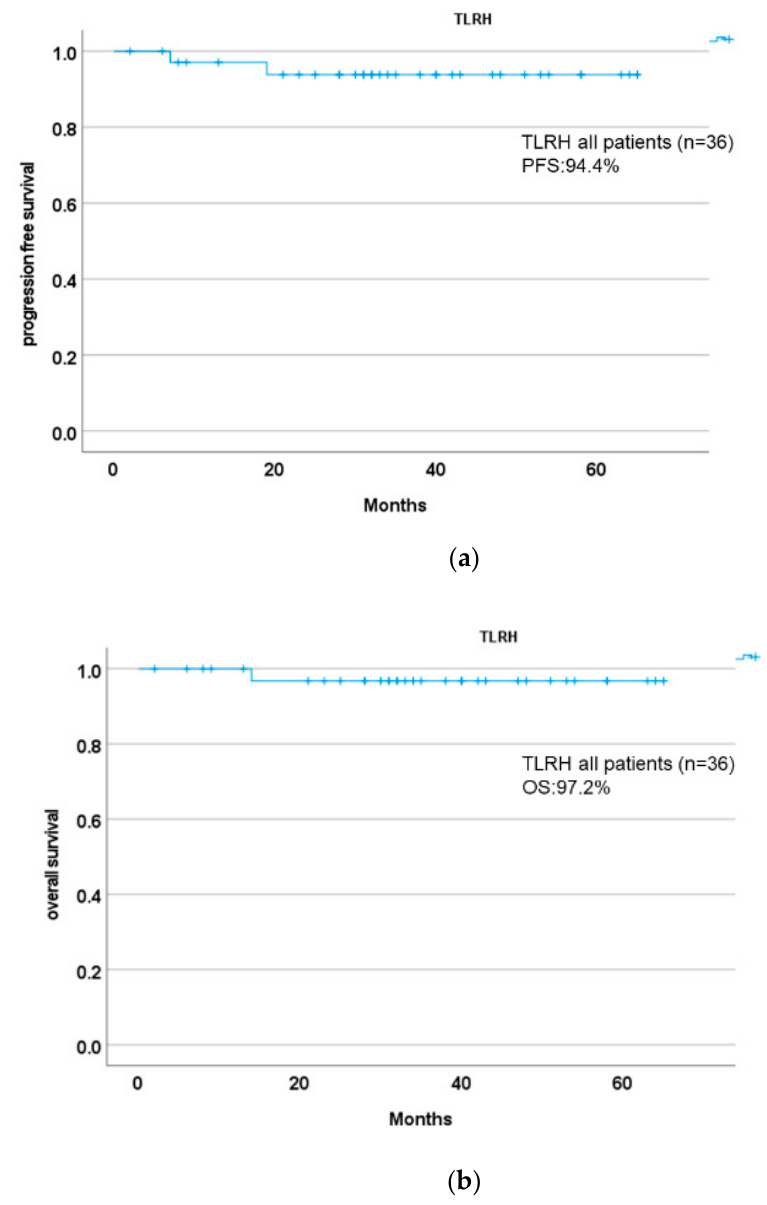
Figure 4. Kaplan–Meier curve for ( a ) progression-free survival and ( b ) overall survival in total laparoscopic radical hysterectomy in all patients.